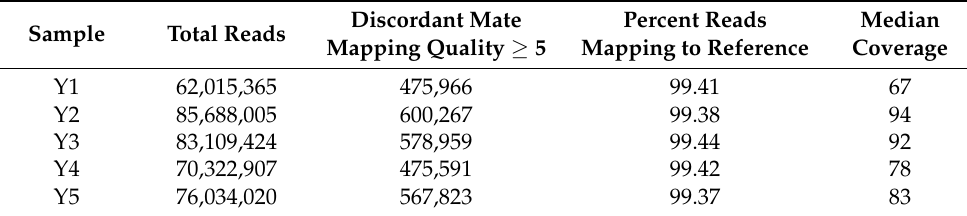
Table 1. Sample sequencing and mapping summary statistics.